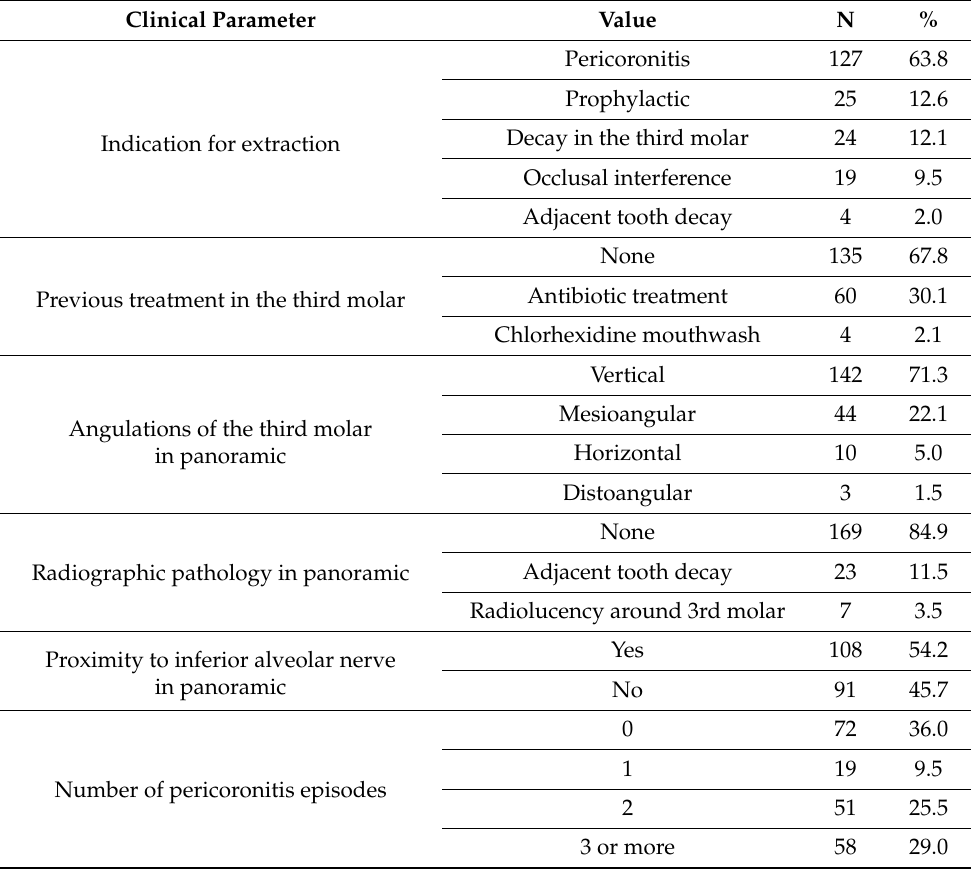
Table 2. Clinical and radiological evaluation of the 3rd molar extraction